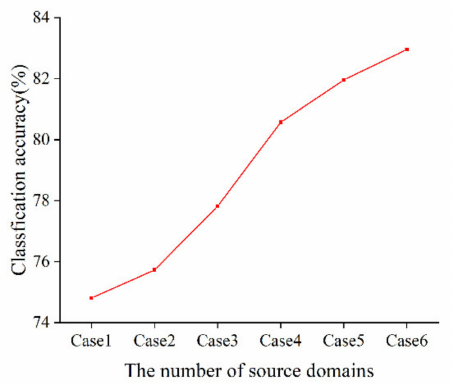
Figure 8. Impact of the number of source domains on the classification